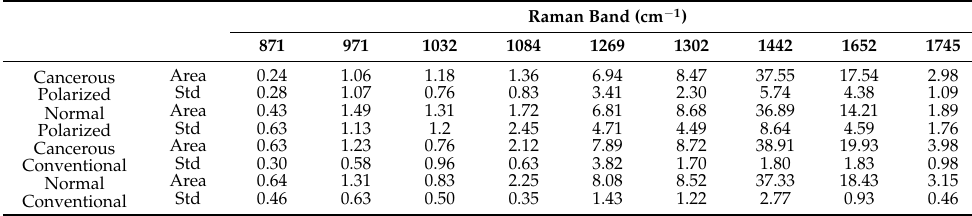
Table 6. Band area with standard deviation of each lipid Raman